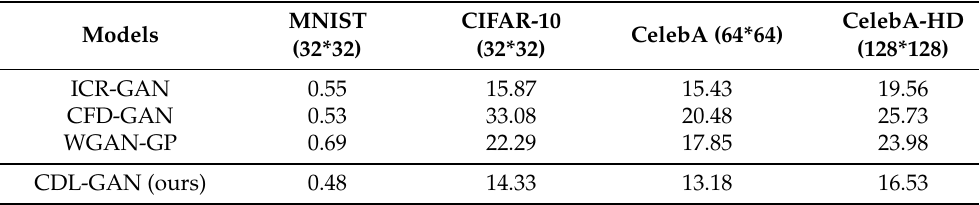
Table 1. Fréchet Inception Distance (FID) scores for CDL-GAN and the existing